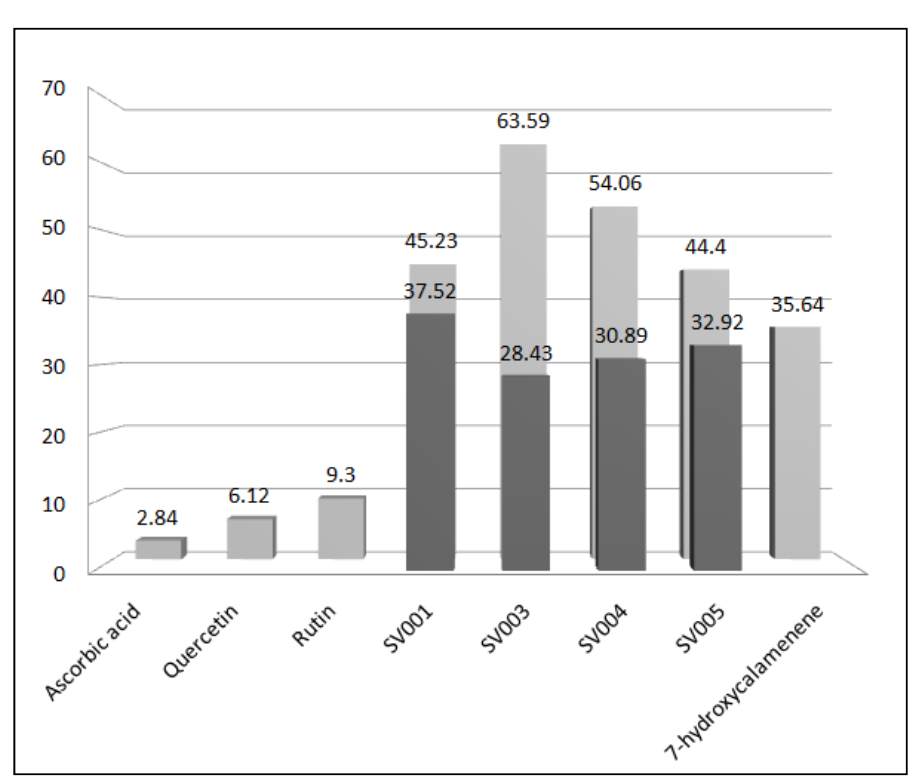
Figure 1. Comparison between presence of 7-hydroxycalamenene ( ) and EC standards, essential oils and